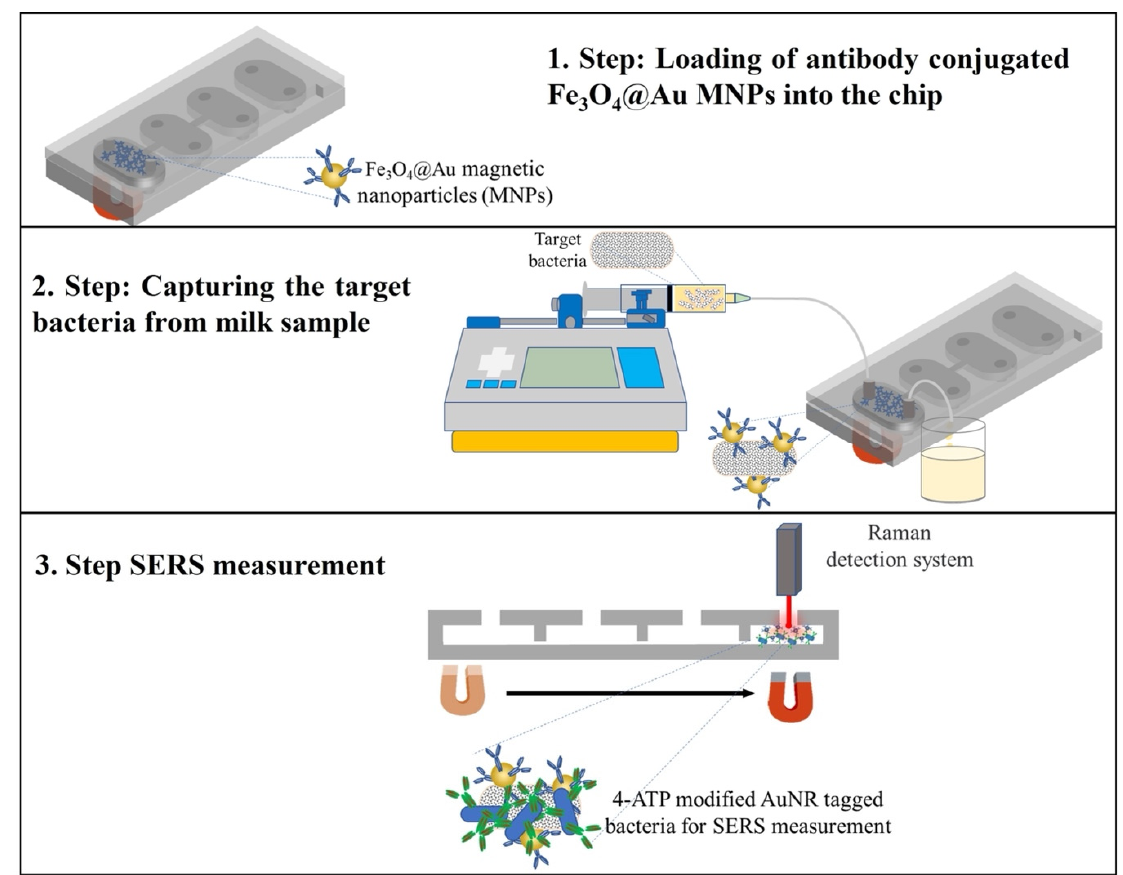
Figure 1. The schematic illustration of experimental strategy using SERS-based sandwich immunoassay for detection of E. coli .